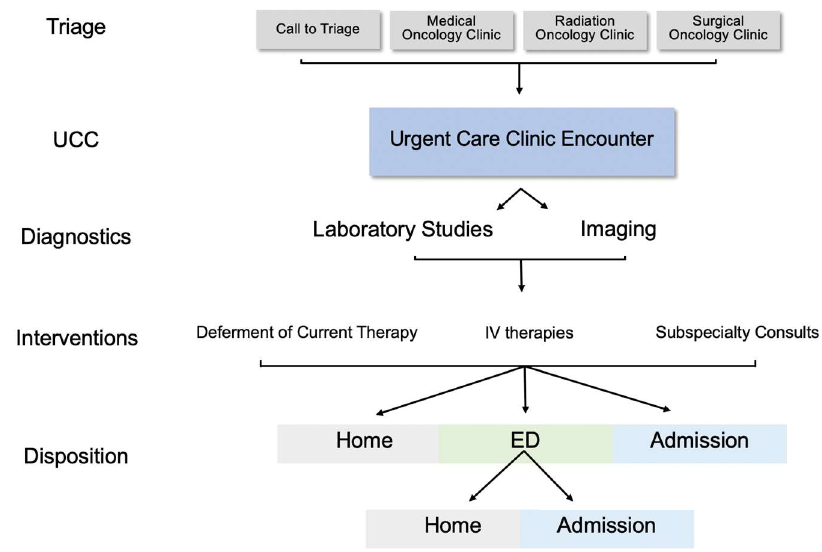
Figure 1. Urgent care clinic encounter work